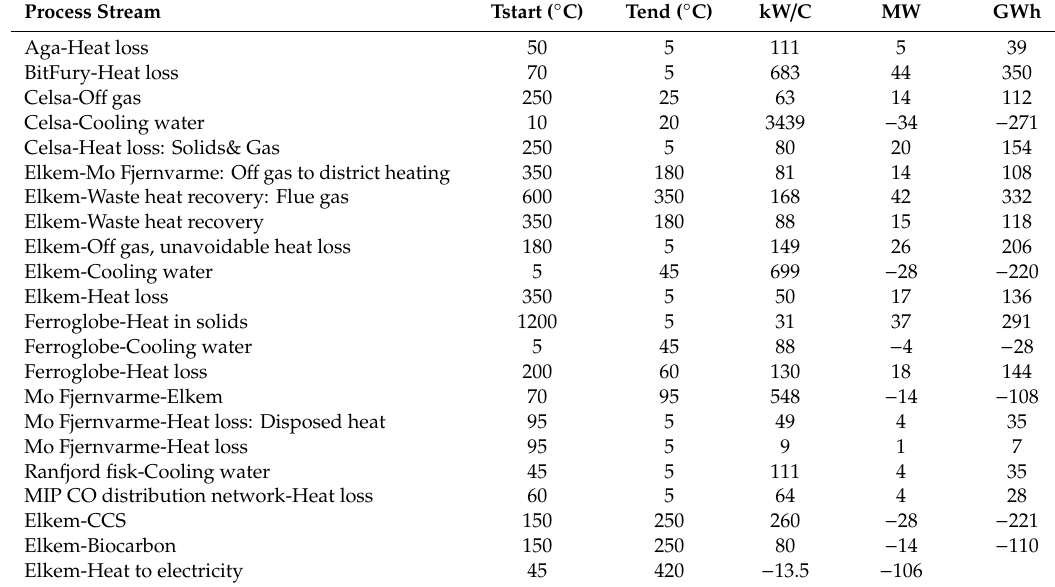
Table A2. Revised (Table A1) stream data including proposed future CCS, biocarbon and heat-to-electricity installations at Elkem.